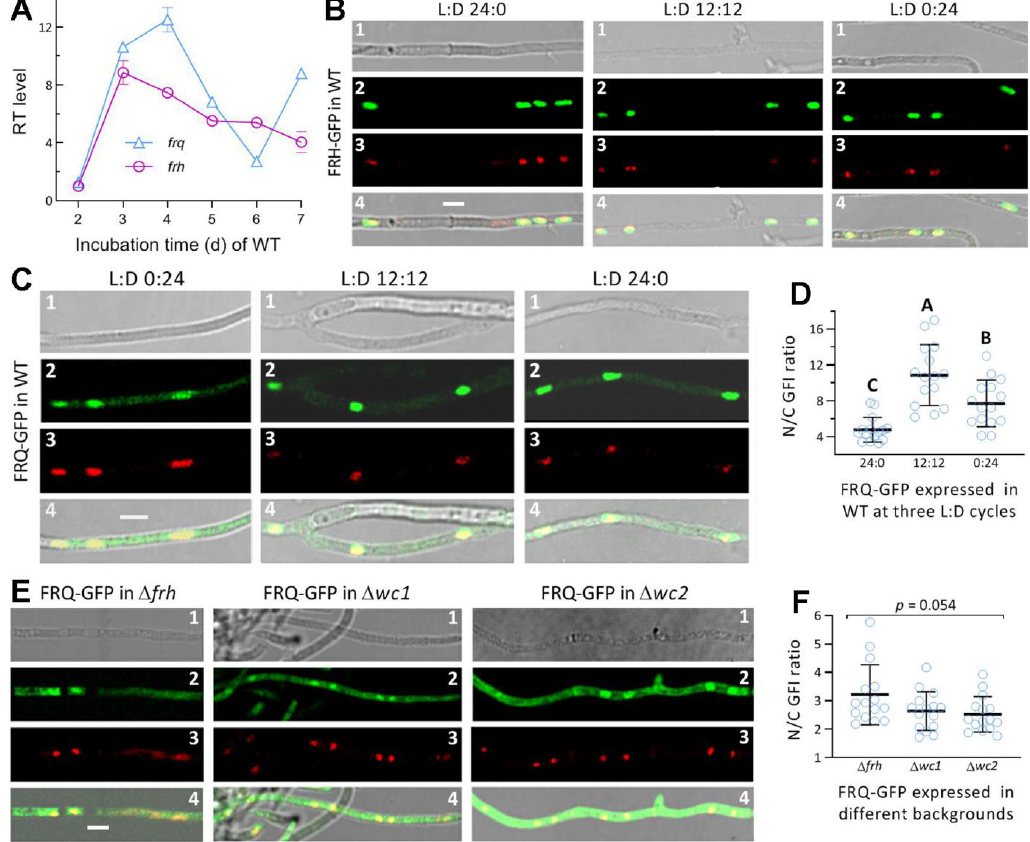
Figure 2. Transcriptional profiles and subcellular localization of FRQ and FRH in M. robertsii . ( A ) Relative transcript (RT) levels of frq and frh in the WT strain during a 7-d incubation on PDA at the optimal regime of 25 °C and L:D 12:12, normalized with the expression levels detected on day 2. ( B , C ) LSCM images (scale bars: 5 μm) for subcellular localization of GFP-tagged FRQ and FRH fusion proteins expressed in the WT strain. Cell samples were taken from the 3 d-old SDBY cultures grown at 25 °C in the L:D cycles of 0:24, 12:12, and 24:0 and stained with the nuclear dye DAPI (shown in red). ( D ) Nuclear versus cytoplasmic green fluorescence intensity (N/C-GFI) ratios of FRQ-GFP in the hyphal cells. Different uppercase letters denote significant differences ( p < 0.01 in Tukey’s HSD test). ( E , F ) LSCM images (scale bars: 5 μm) and N/C-GFI ratios for subcellular localization of FRQ-GFP expressed in the 3 d-old SDBY cultures of the Δ frh , Δ wc1 and Δ wc2 mutants at 25 °C and L:D 12:12, respectively. Images 1 – 4 in each panel are bright, expressed (green), stained (red nuclei) and merged (yellow nuclei) views of the same field, respectively. Error bars: standard deviations (SDs) of the means from three cDNA samples ( A ) analyzed via qPCR or 15 cells in the examined hyphae ( D , F ).